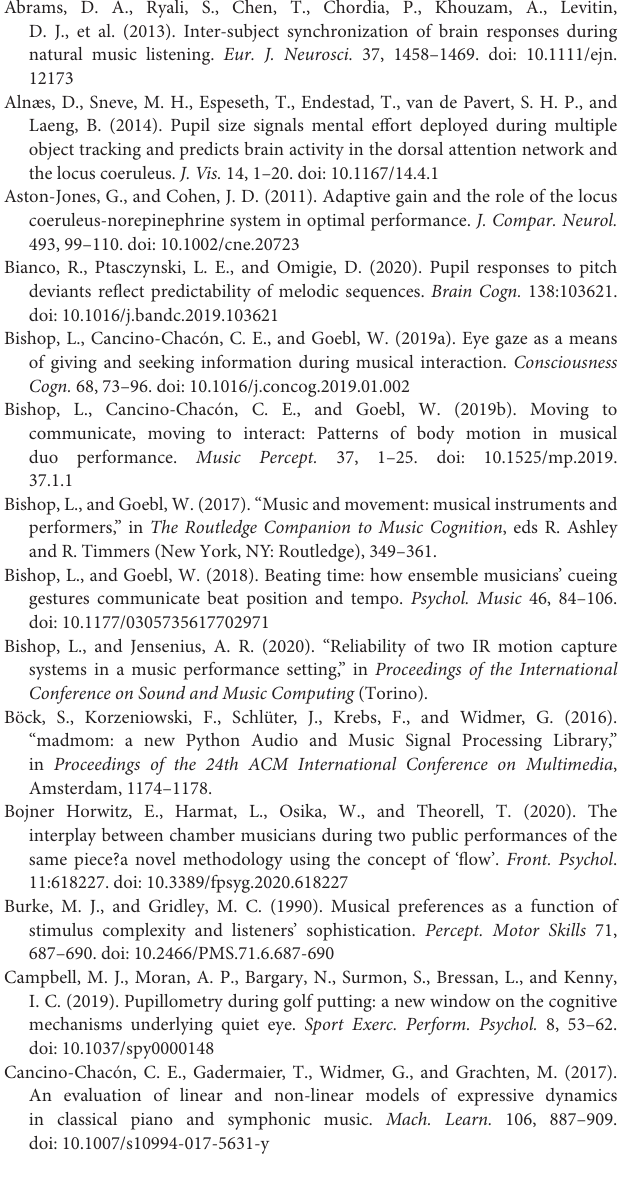
Supplementary Figure 1 | Violin plots showing the distribution of Quantity of Arm Motion values for each musician across pieces.